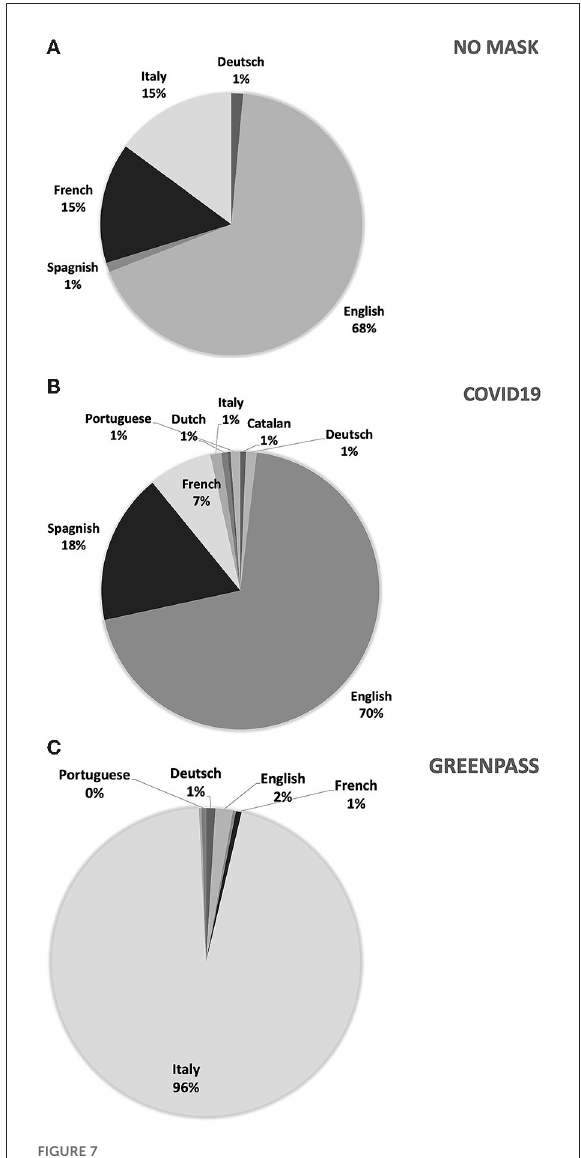
FIGURE7 (A–C) Comments for languages (% on European